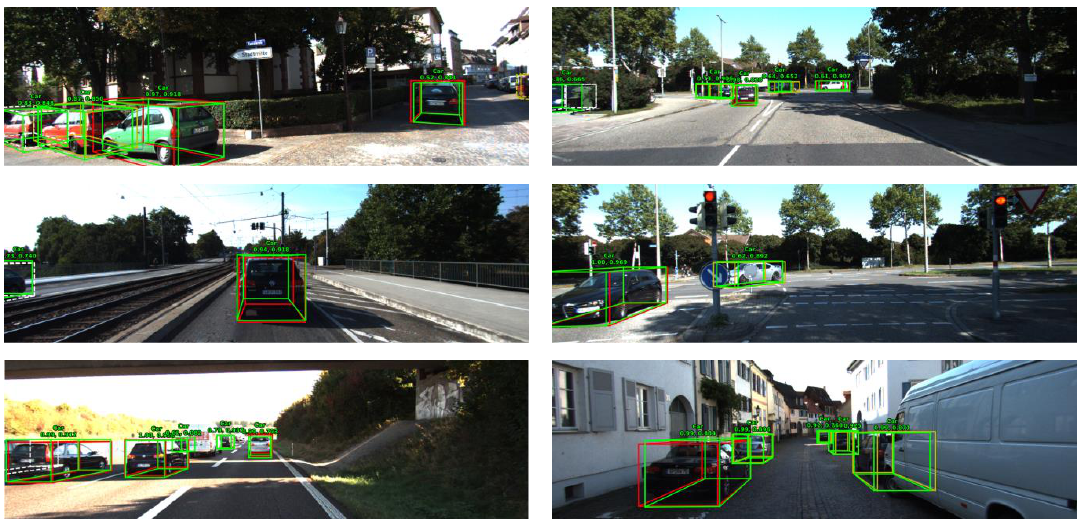
Figure A2. Visualizations of KDA3D results on the KITTI val set. The predictions are shown with green 3D bounding boxes. The ground-truth boxes are shown in different colors according to their difficulty levels, where “Easy” instances are shown in red, “Moderate” instances are shown in yellow, and “Hard” instances are shown in white. The digits beside each box denote the confidence score (left) and the IoU (right). Best viewed in color (zoom in for details).